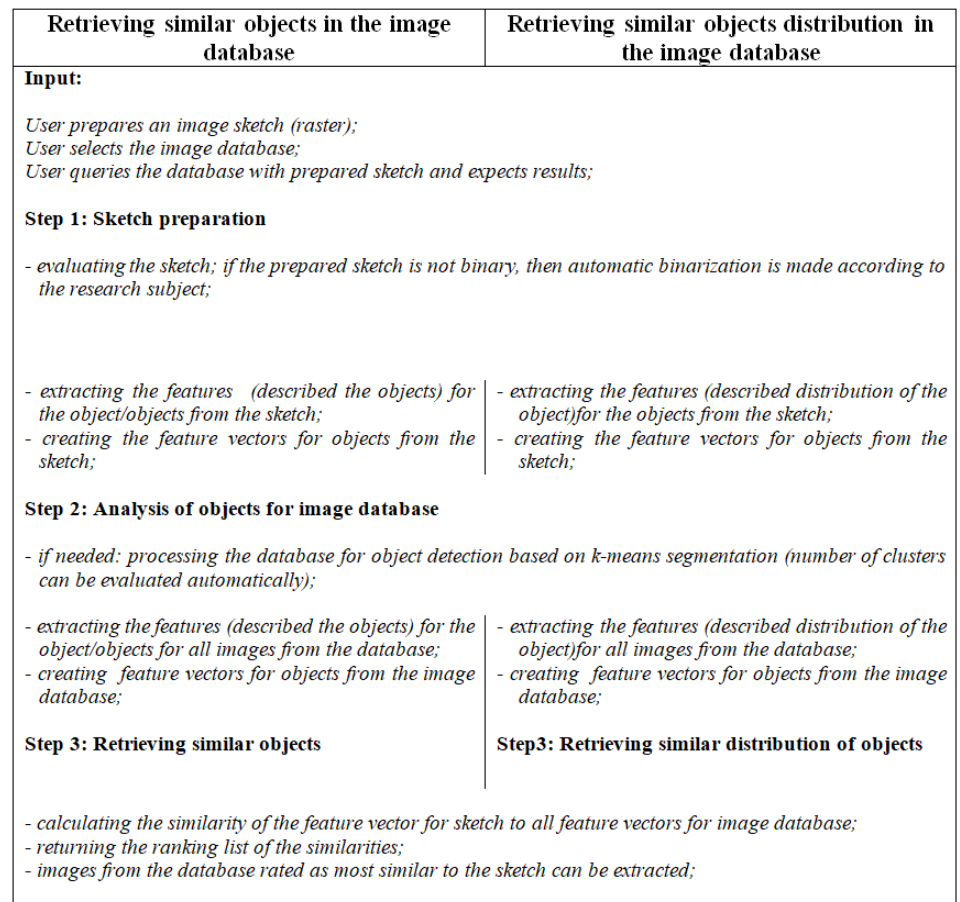
Figure 3. An example of the analysed images ( a ), the results of porosity detection ( b ) and image binarisation ( c ).